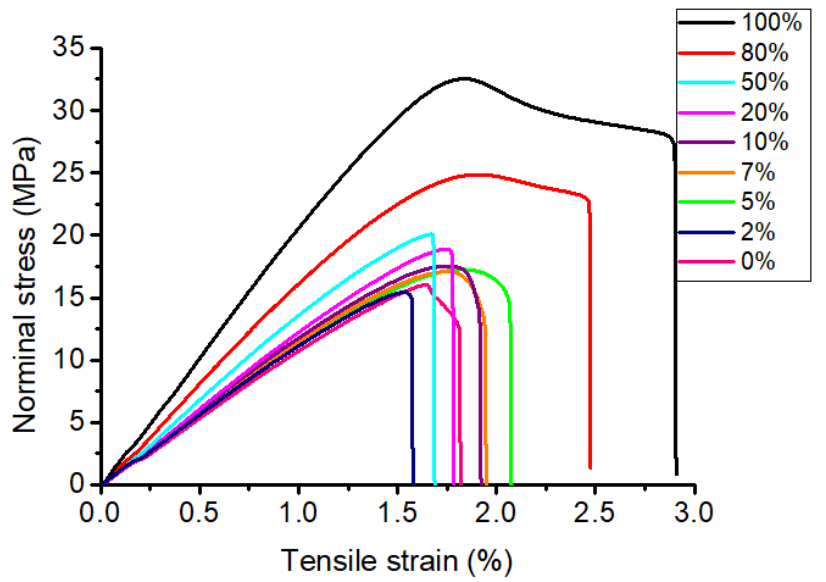
Table 2. Mechanical properties of PLA material with a variation of infill density.